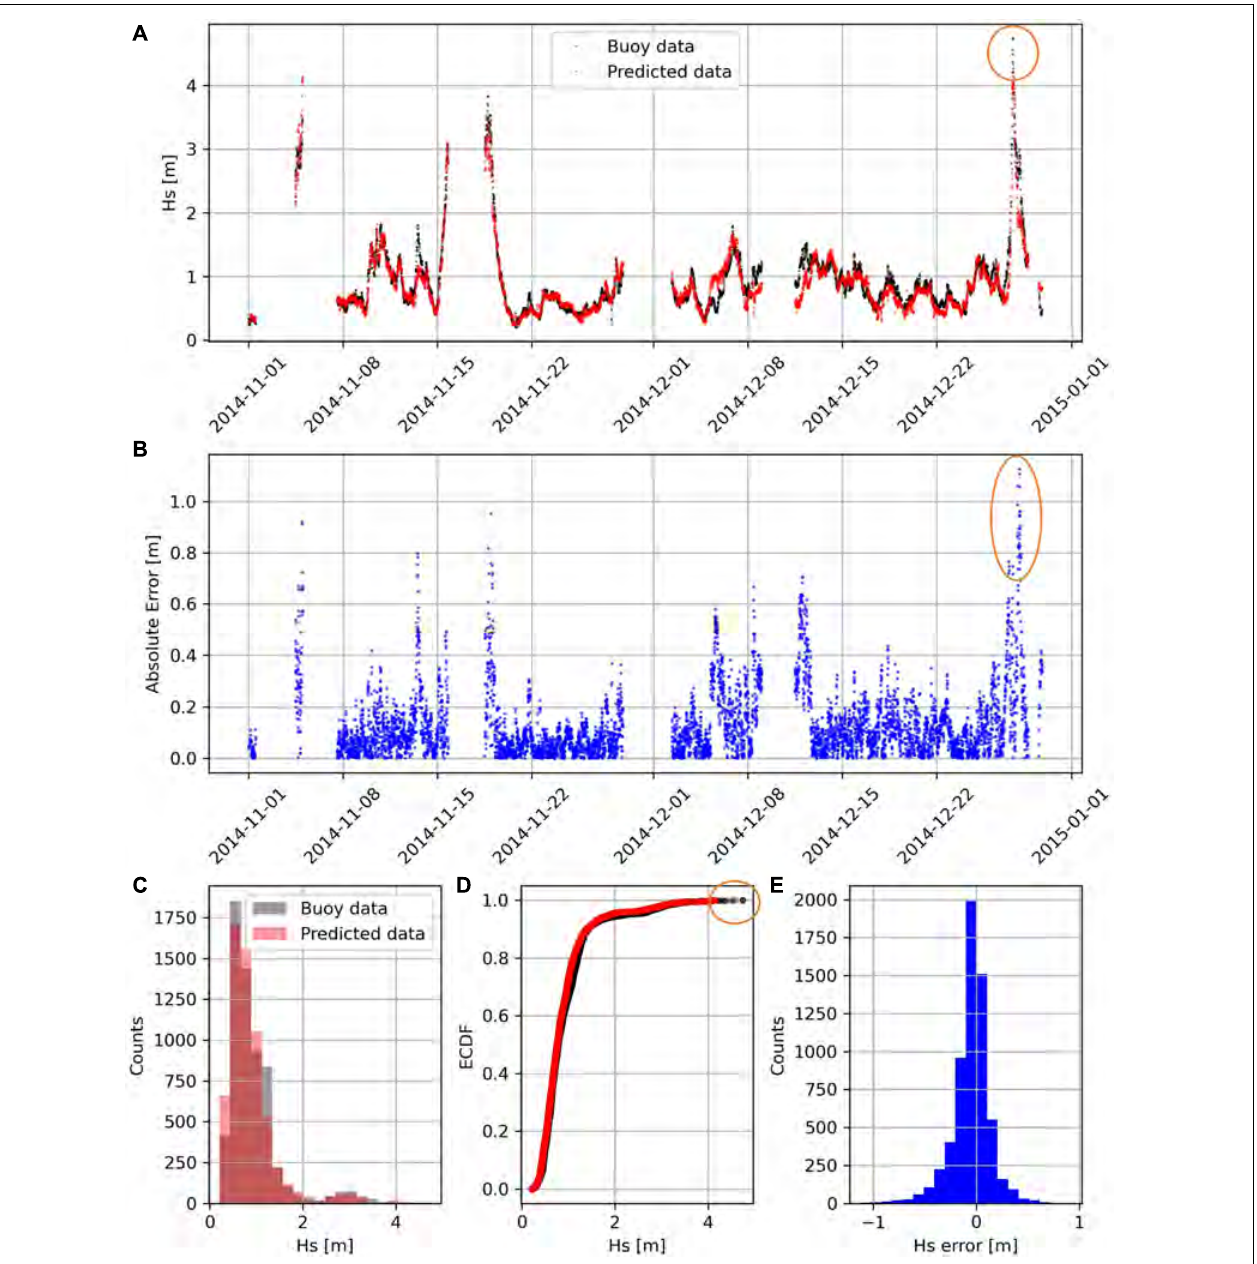
FIGURE 12 | Significant wave height (H s ) measured by the buoy (in black) and predicted by the Random Forest model (20 predictors) (in red) displayed in the time plot (A) , the histogram (C) , and the ECDF plot (D) . The deviation between the two-time series is displayed (in blue) in the time plot (B) , and the histogram (E)